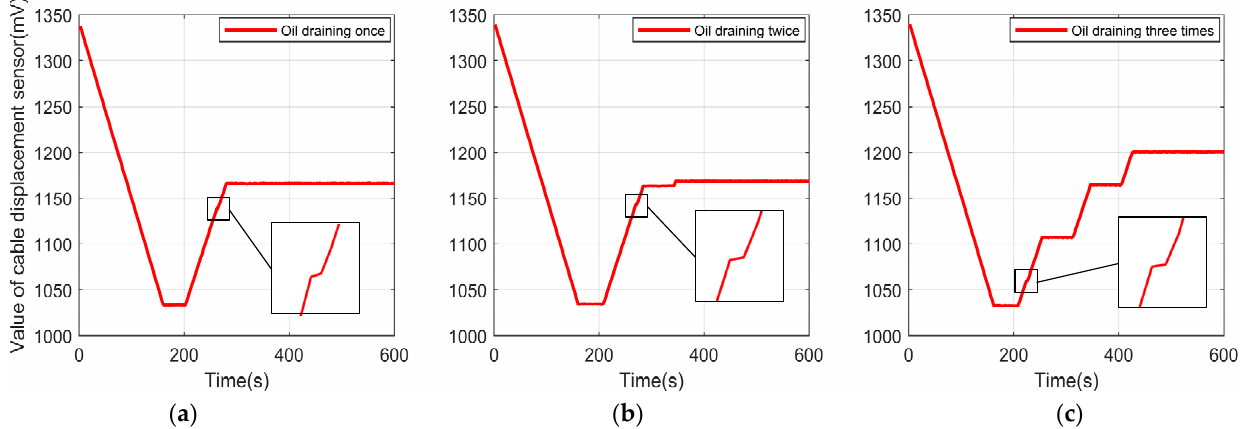
Figure 13. ( a ) Value of the cable displacement sensor when the oil is draining once; ( b ) Value of the cable displacement sensor when the oil is draining twice; ( c ) Value of the cable displacement sensor when the oil is draining three times